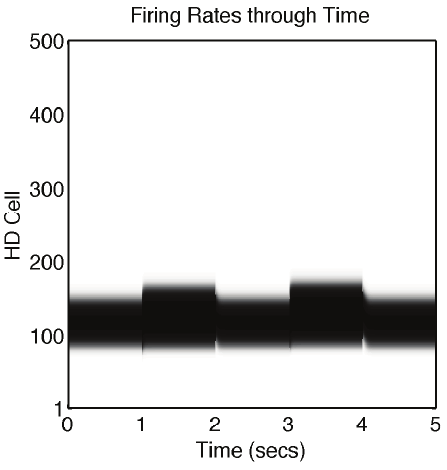
Figure 12. Path integration performance with no axonal conduction delays. Firing rates of the head direction (HD) cells recorded during the testing phase of a model simulated with an axonal conduction delay of 0 ms, and trained with rotational velocity of 360 0 /s. Conventions are as for the top-right plots in Figures 7 and 8. It is evident that the model fails to learn to perform path integration of head direction.